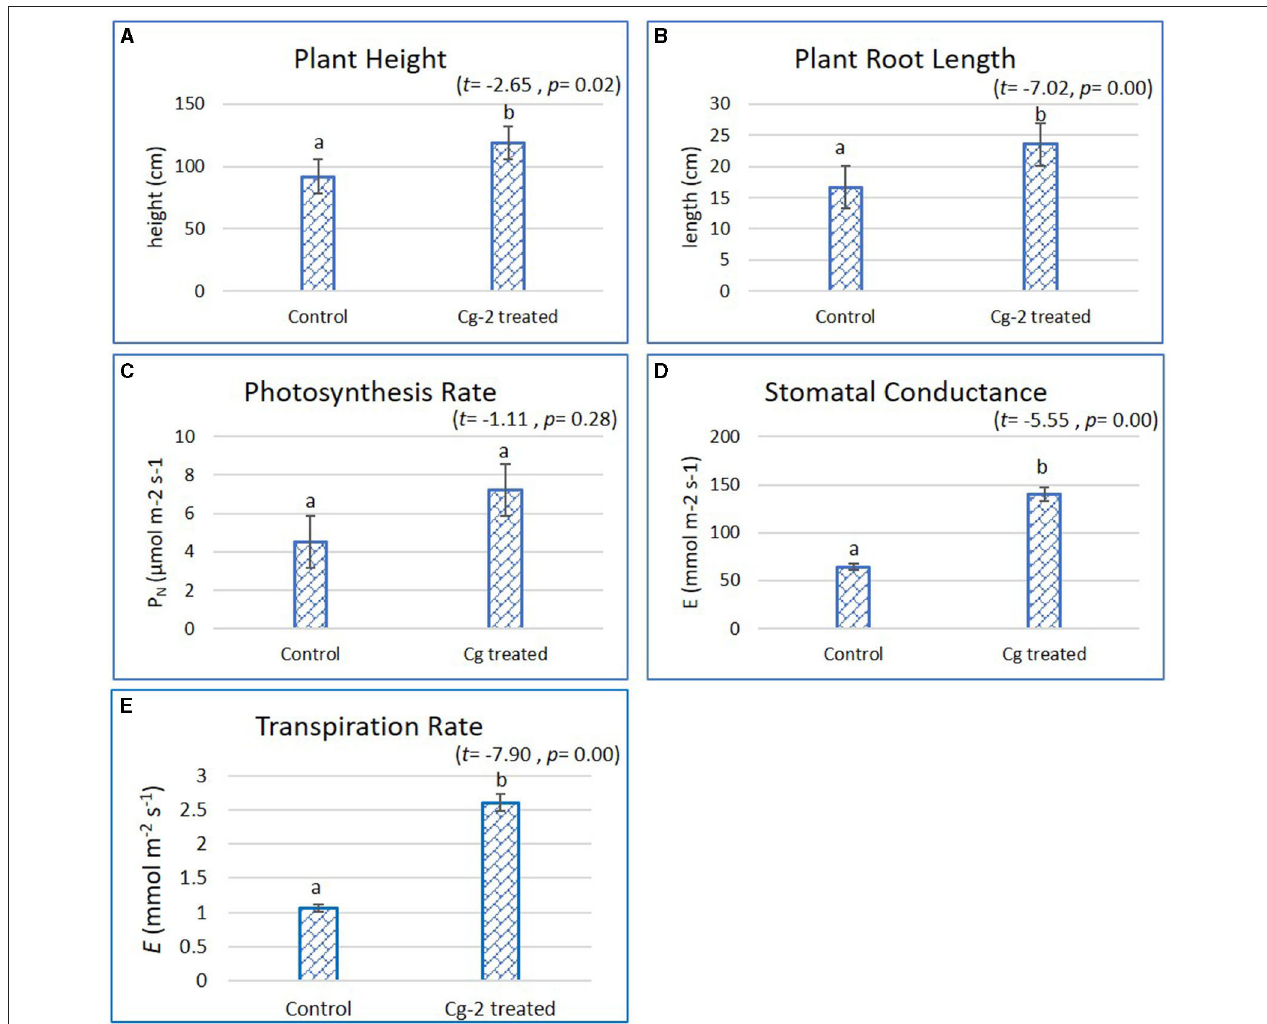
FIGURE 1 | Effect of Chaetomium globosum (Cg-2) on growth and development of tomato plants (cv. Pusa Rohini). (A) Plant Height; (B) Plant Root Length; (C) Photosynthesis Rate; (D) Stomatal Conductance and (E) Transpiration Rate.